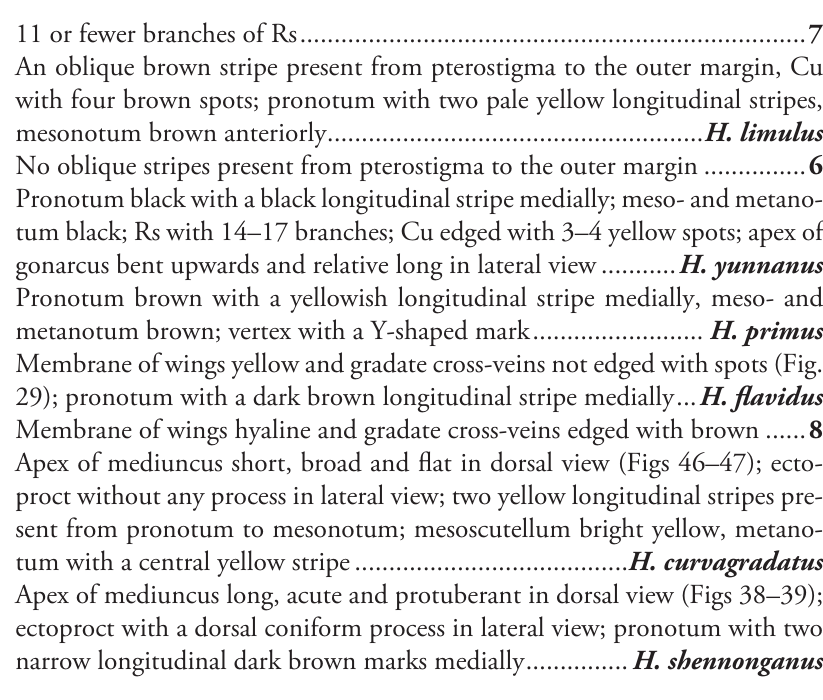
Heterosmylus processus sp. n. http://zoobank.org/18F14A57-CA9C-4329-BA1F-F885461CCCB6